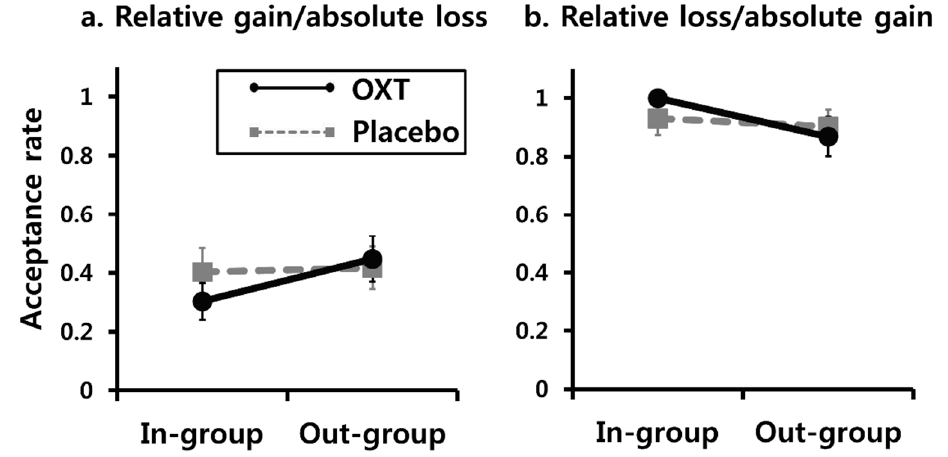
Figure 4. The mean acceptance rates across conditions in the incongruence condition separately displayed for ( a ) the relative gain/absolute loss trials (i.e., downward comparison) and ( b ) the relative loss/absolute gain trials (i.e., upward comparison). Error bars represent the standard errors of the mean for each condition.